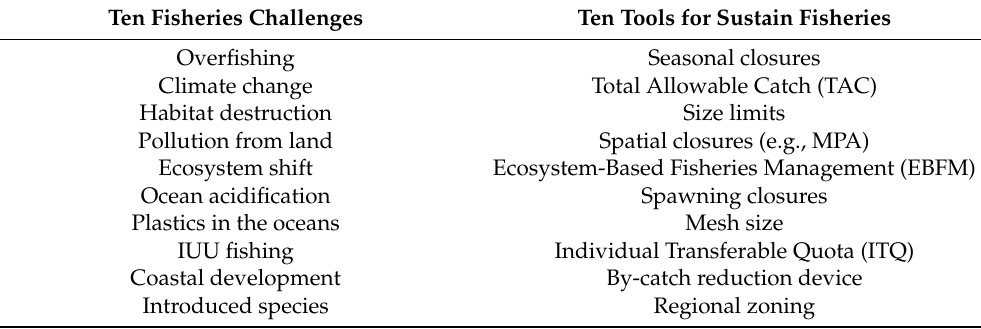
Table 3. Ten main challenges and ten main tools for sustaining fisheries (n = 133).